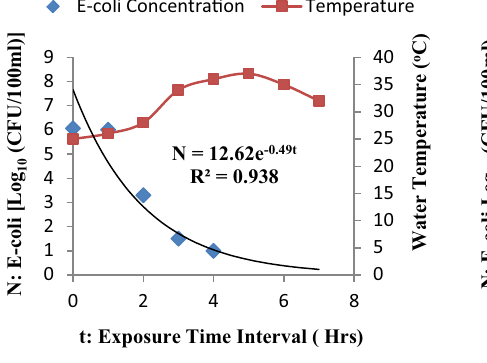
Fig. 13 a and b Day 6 Side- By-Side Performance Curves of the Improved SODIS and the Conventional